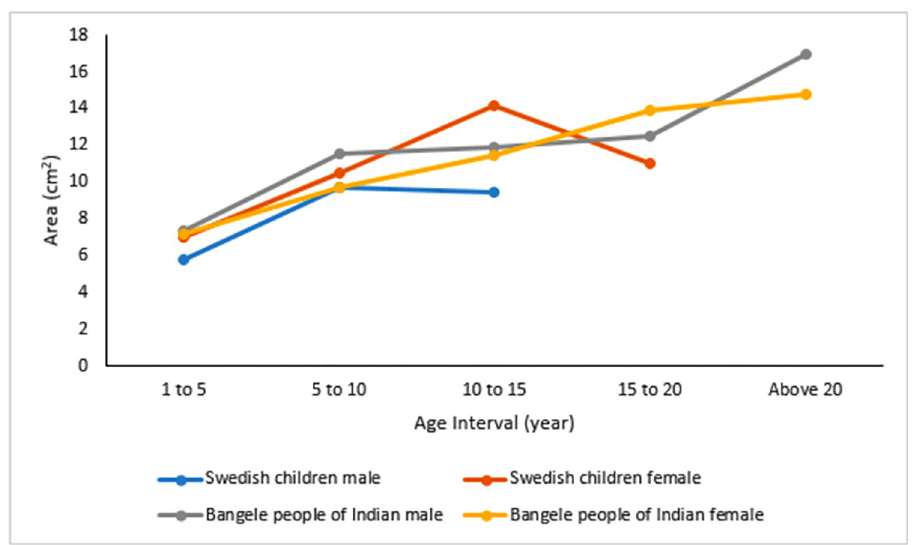
Fig 4. Line graph showing growth rate and size of mastoid air cell systems of studies that utilized 5 year age grouping. X-axis displays the age range in years, and Y-.axis illustrates the size of the mastoid air cells.